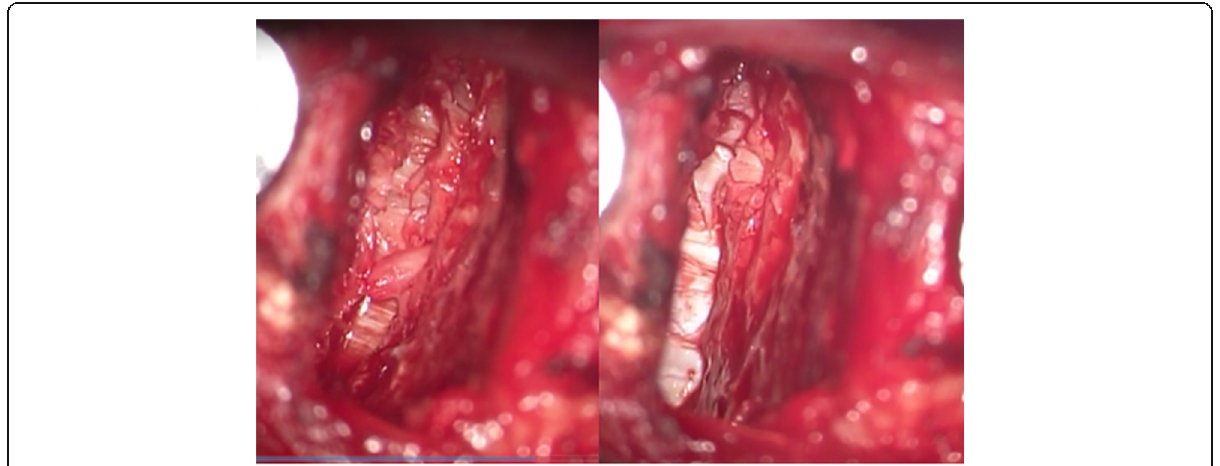
Fig. 2 Intraoperative photograph before (left) and after (right) resection of the PLL